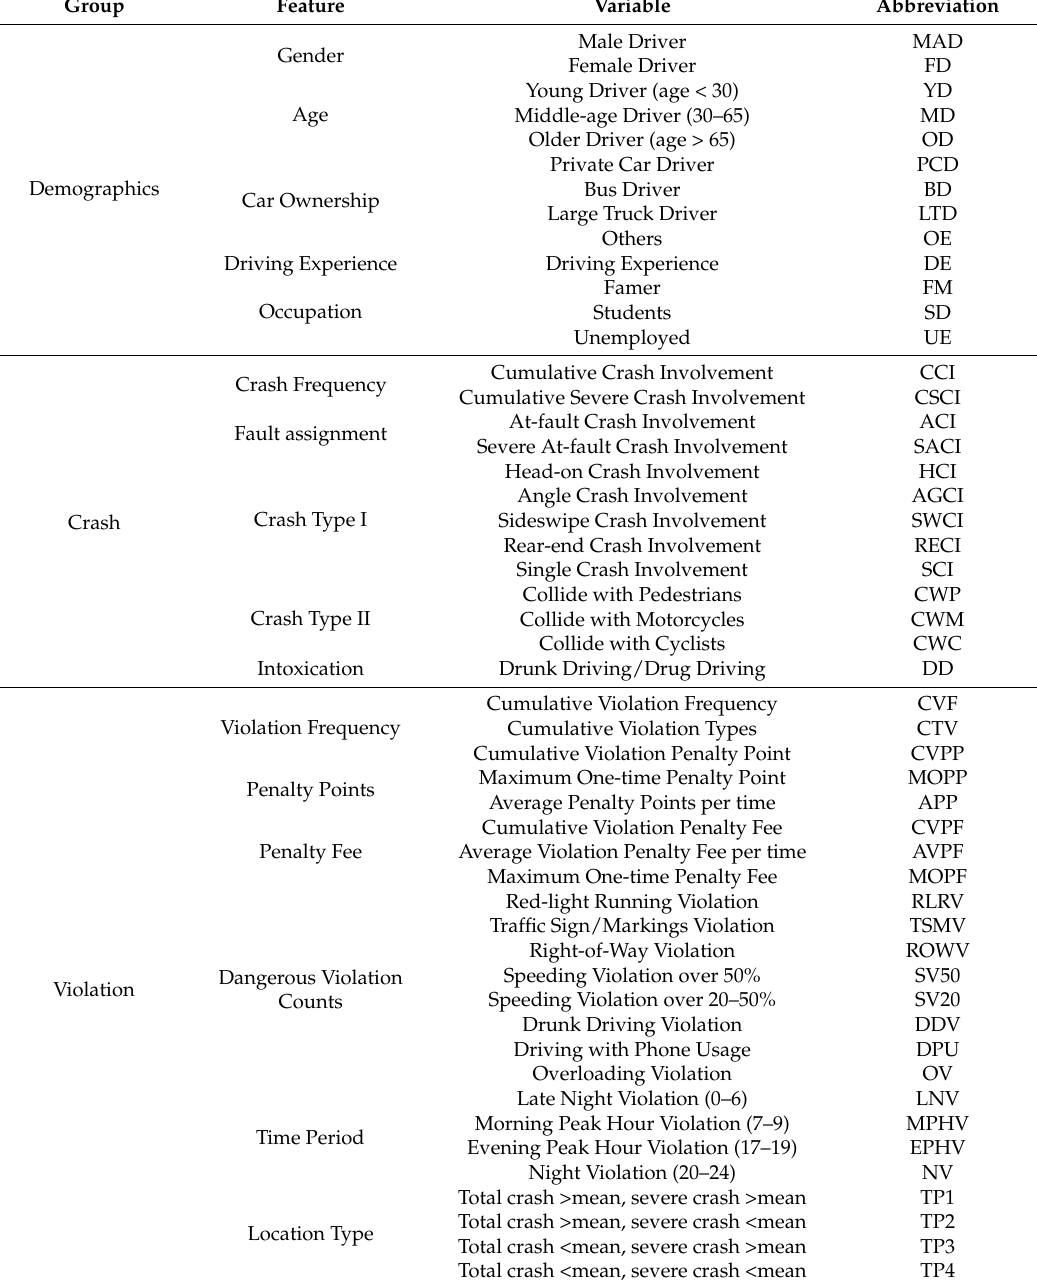
Table 2. Final features extracted from crash/violation